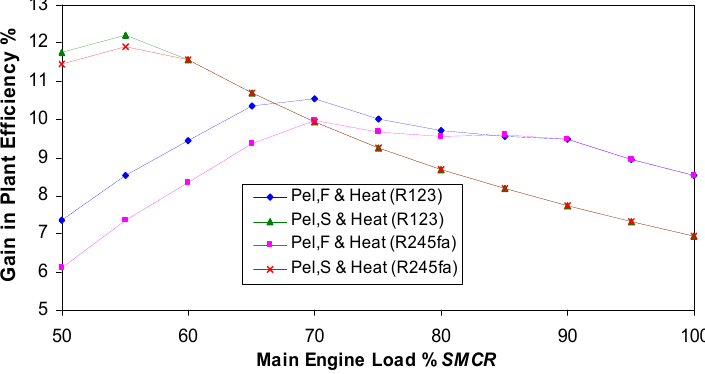
Figure 20. Gain in Ship Power Plant Efficiency with organic fluids—heat and electrical power.